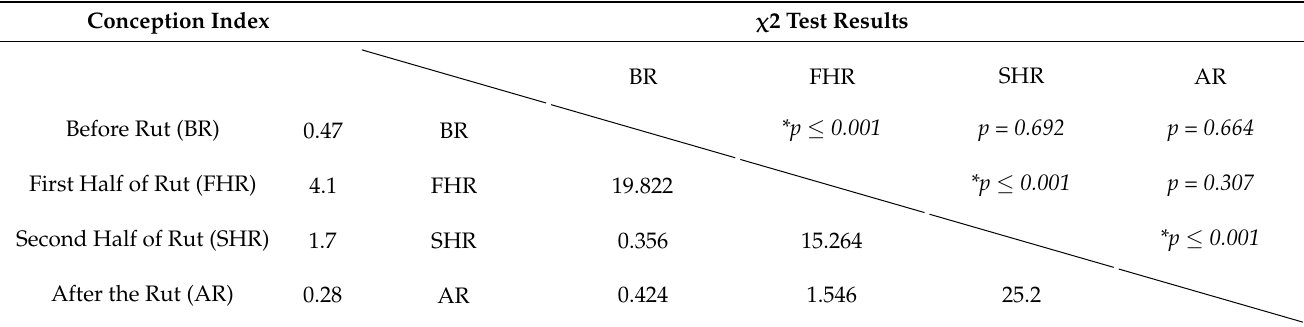
Table 2. The result of analysis of conception